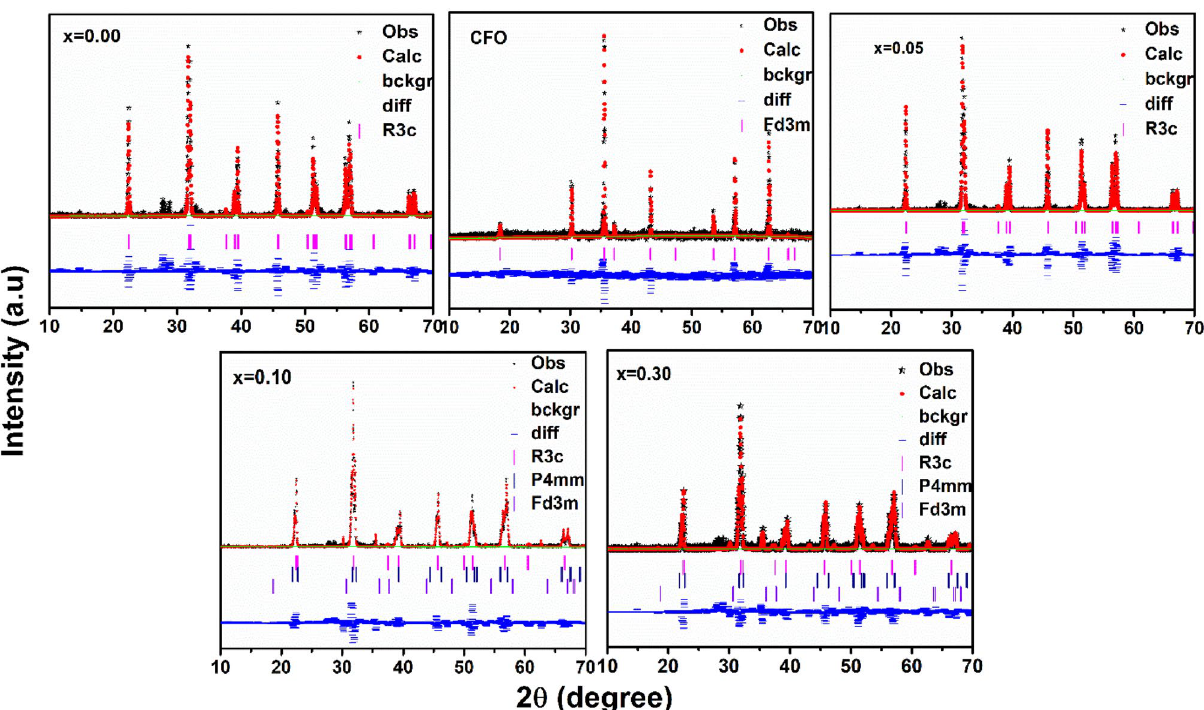
Figure 2. Rietveld refinement profiles of the X-ray diffraction data for (1 − x) BFO–xCFO (CFO, x = 0.00, 0.05, 0.10 and 0.30) ceramic samples. Observed (Obs), calculated (Calc), and difference (diff). The Bragg reflections are denoted by vertical sticks and solid lines are fitted in background.